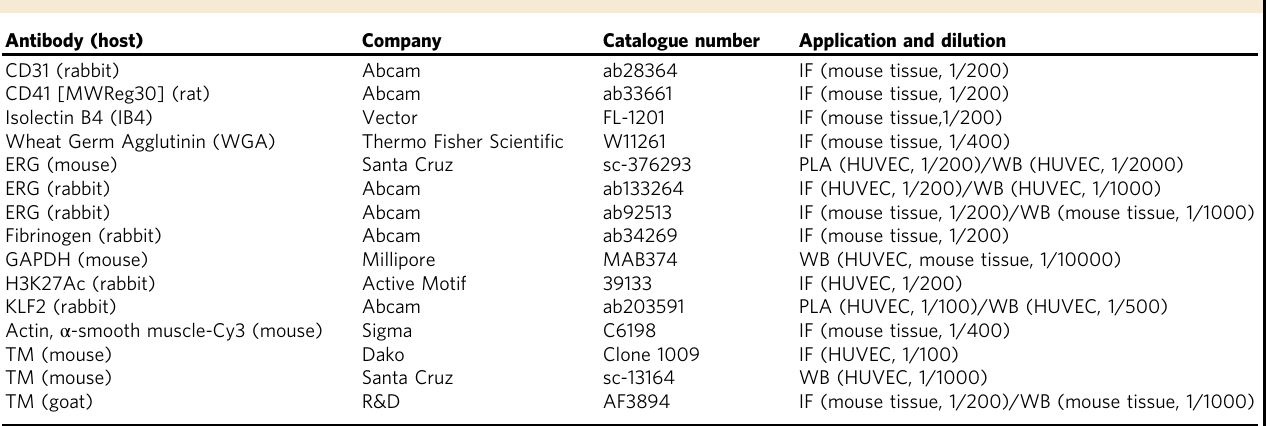
List of antibodiesused forimmuno fl uorescence (IF),westernblot (WB)and proximityligation assay(PLA).Dilution of the antibodiesused foreachspeci fi c applicationis speci fi ed in theright column (in